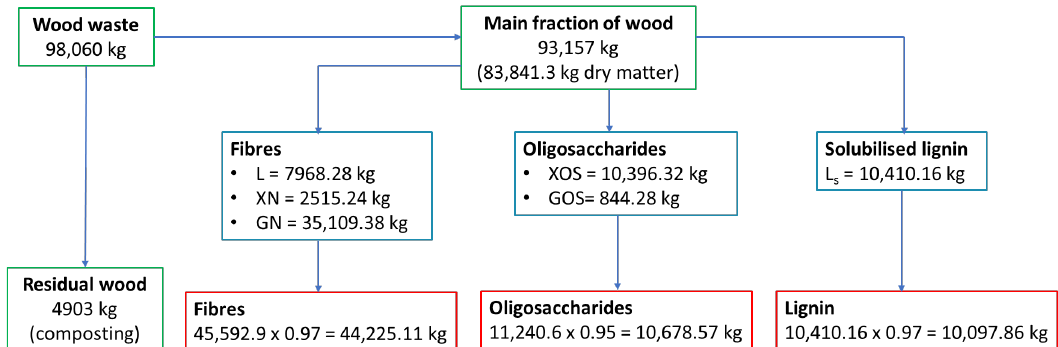
Figure 9. Products and their amounts obtained from wood steam refining: green boxes indicate feedstock, blue boxes show the products’ amounts after steam refining treatment, and red boxes show the products’ amounts after